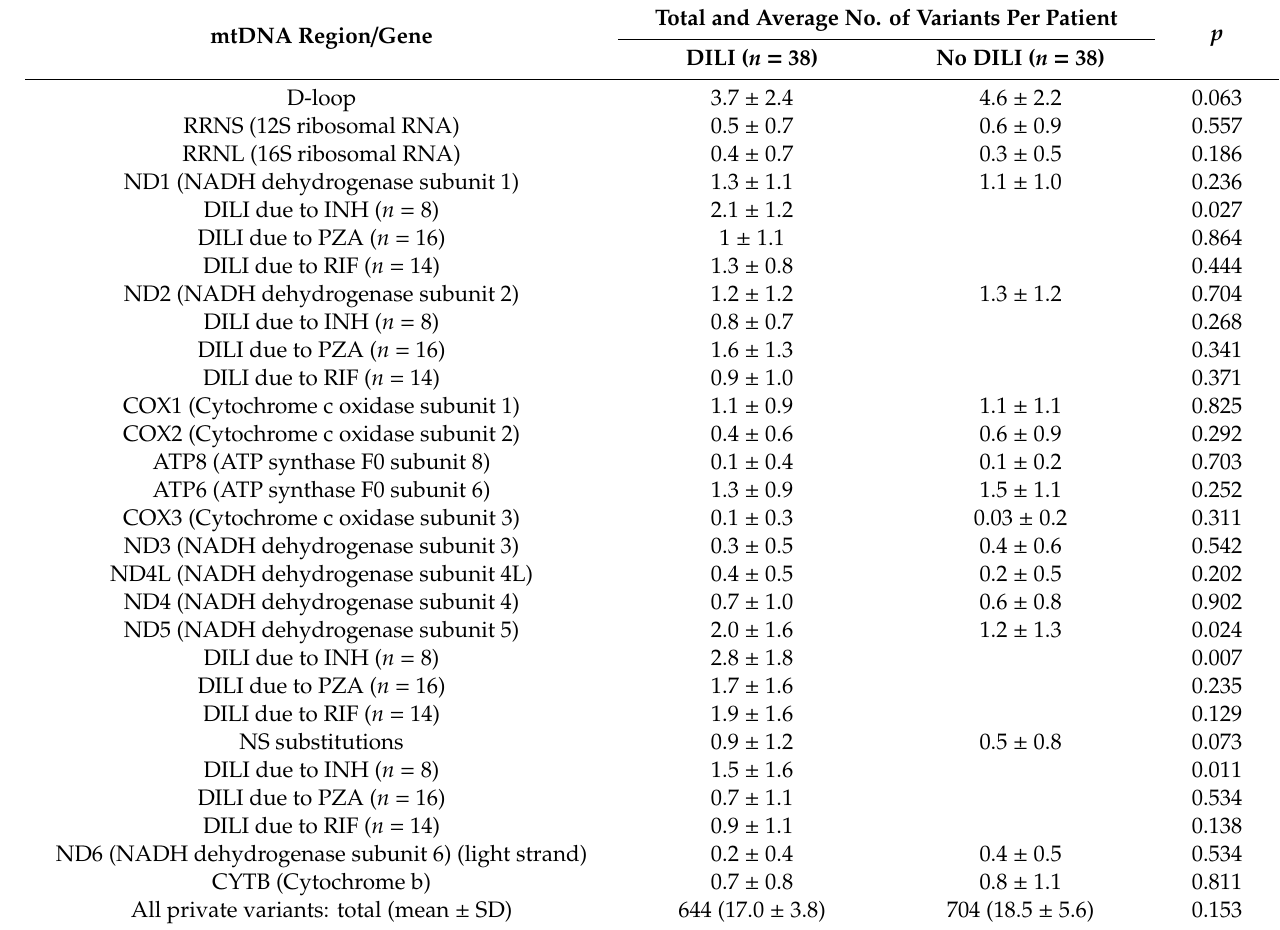
Table 4. Average number of private variants (with haplogroup-associated variants subtracted from total variants) in mtDNA genes for TB patients with DILI ( n = 38) and without DILI ( n =